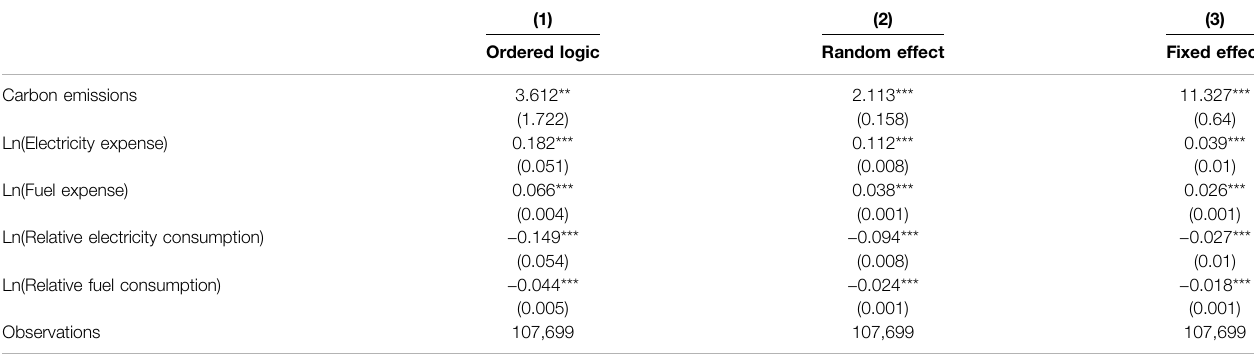
TABLE 3 | Robust test, with cluster robust standard